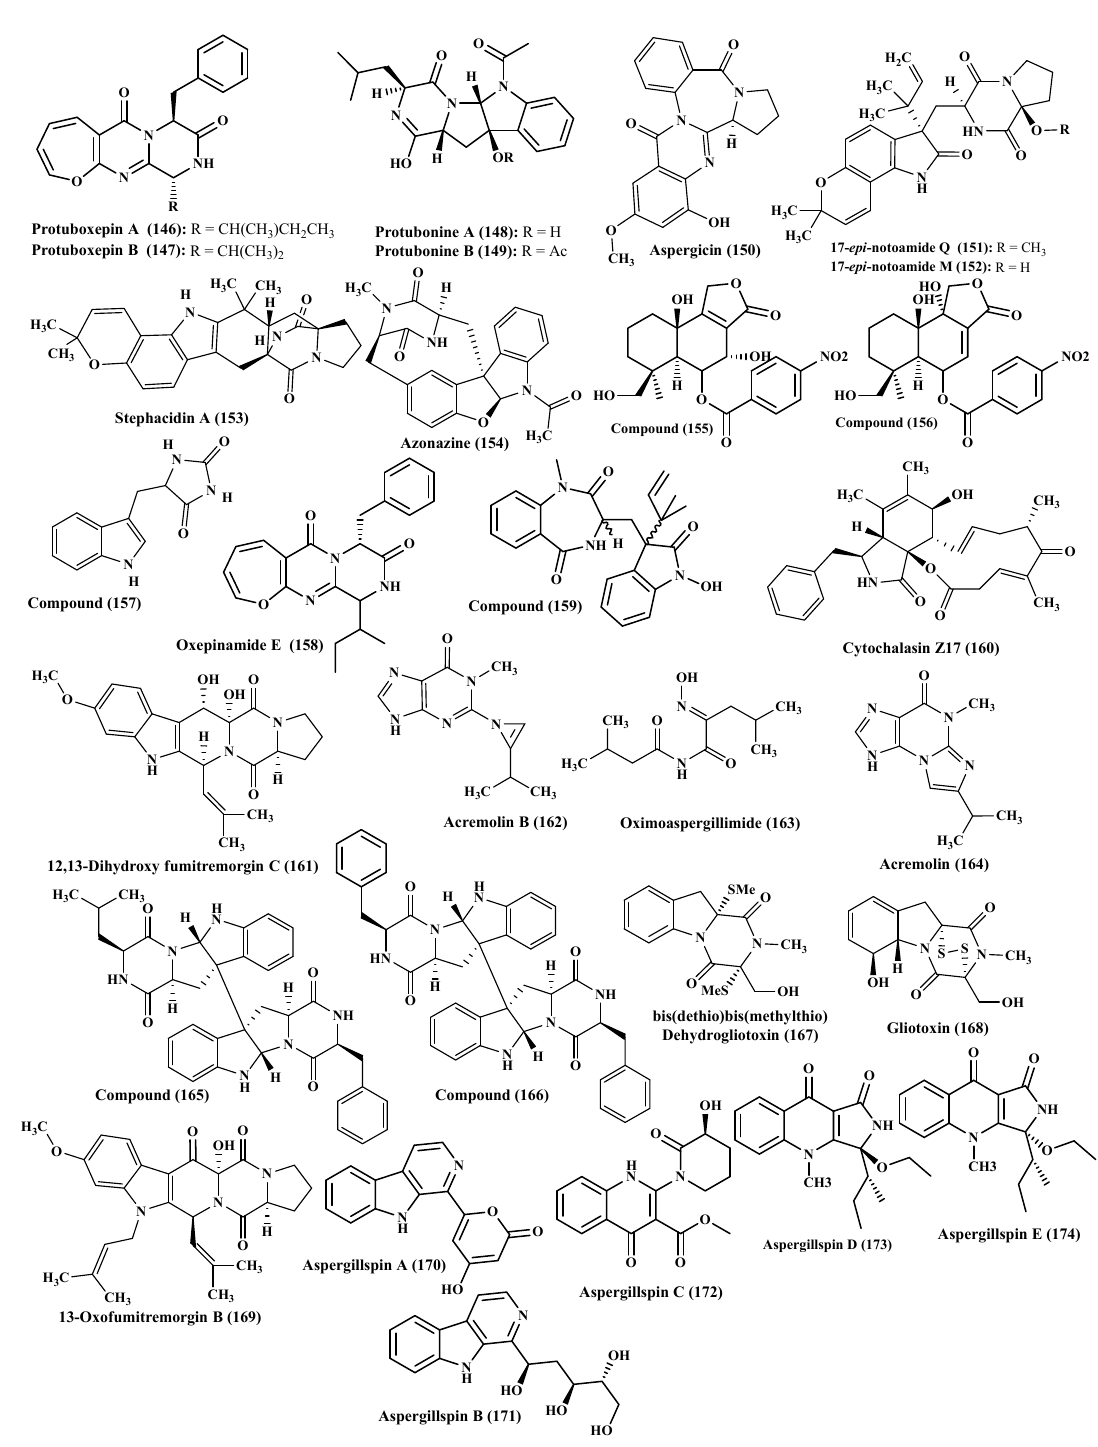
Figure 9. Alkaloids isolated from miscellaneous Aspergillus species.